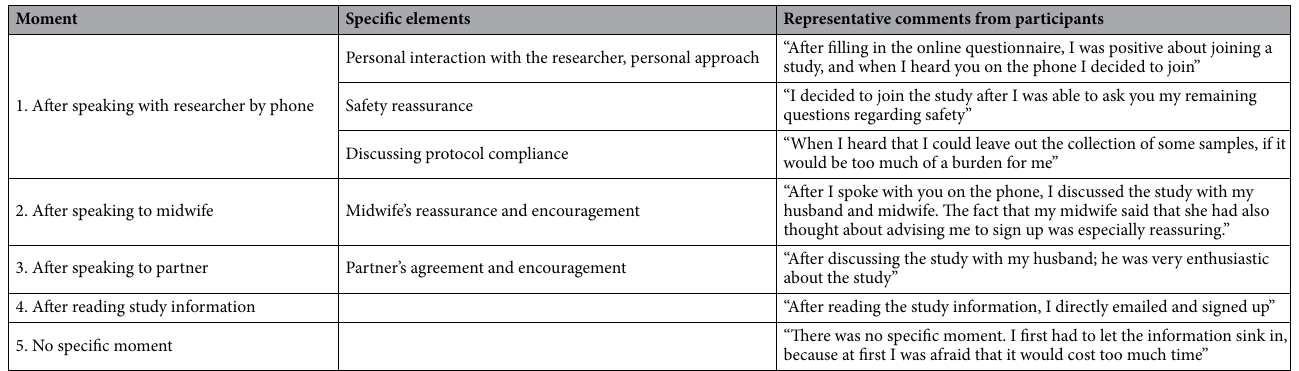
Table 4. Description of reported moments of decision to participate in the pilot